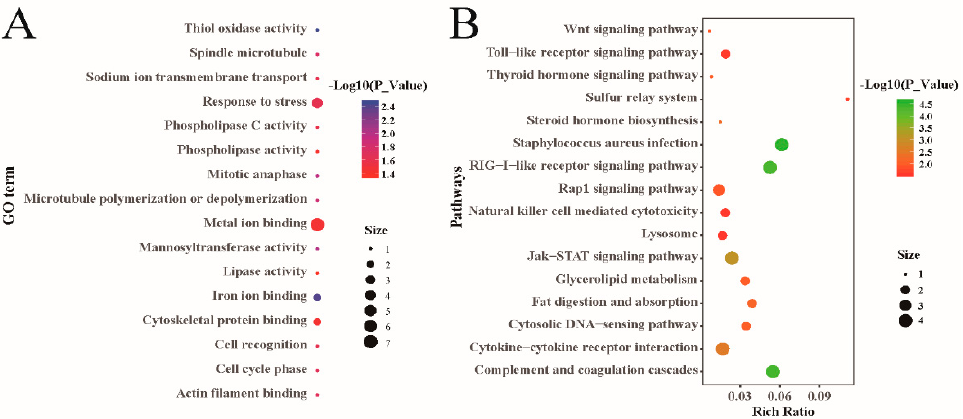
Figure 3. Gene ontology (GO) ( A ) and Kyoto encyclopedia of genes and genomes (KEGG) ( B ) analysis for the regional candidate genes with genome-wide significant association.